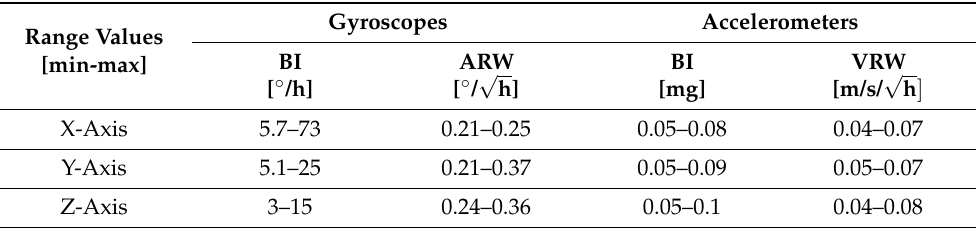
Figure 10. Allan deviation of gyros, axis z : single SensorTile vs. prototype. Table 4. Variation interval, for each sensing axis, of accelerometer and gyroscope errors affecting the inertial sensors involved in the realized prototype.